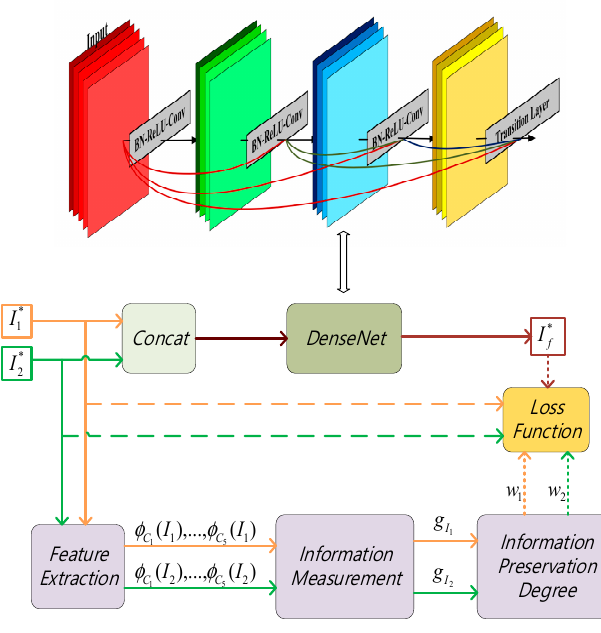
Figure 2. Fusion